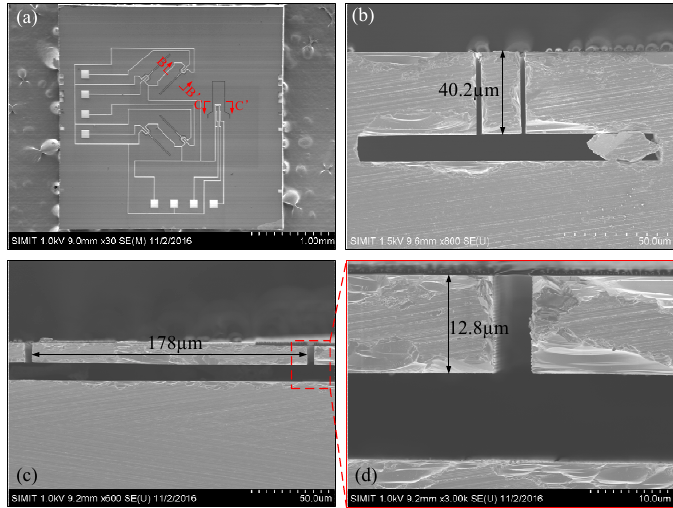
Figure 5. ( a ) Top-view SEM image of the whole tri-axis sensor chip. ( b ) Cross-sectional view of the X- /Y-axis cantilever cut along along B-B’ in ( a ). ( c ) Cross-sectional view of the Z-axis cantilever cut along C-C’ in ( a ). ( d ) Magnified cross-sectional locaiton of the Z-axis cantilever.